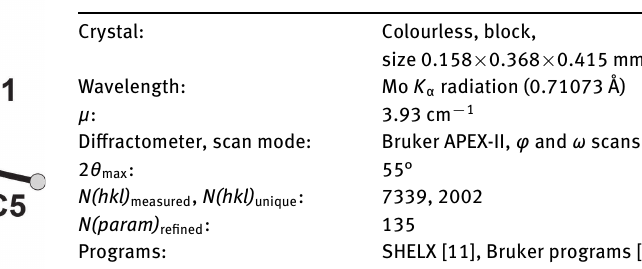
Table 1: Data collection and handling.